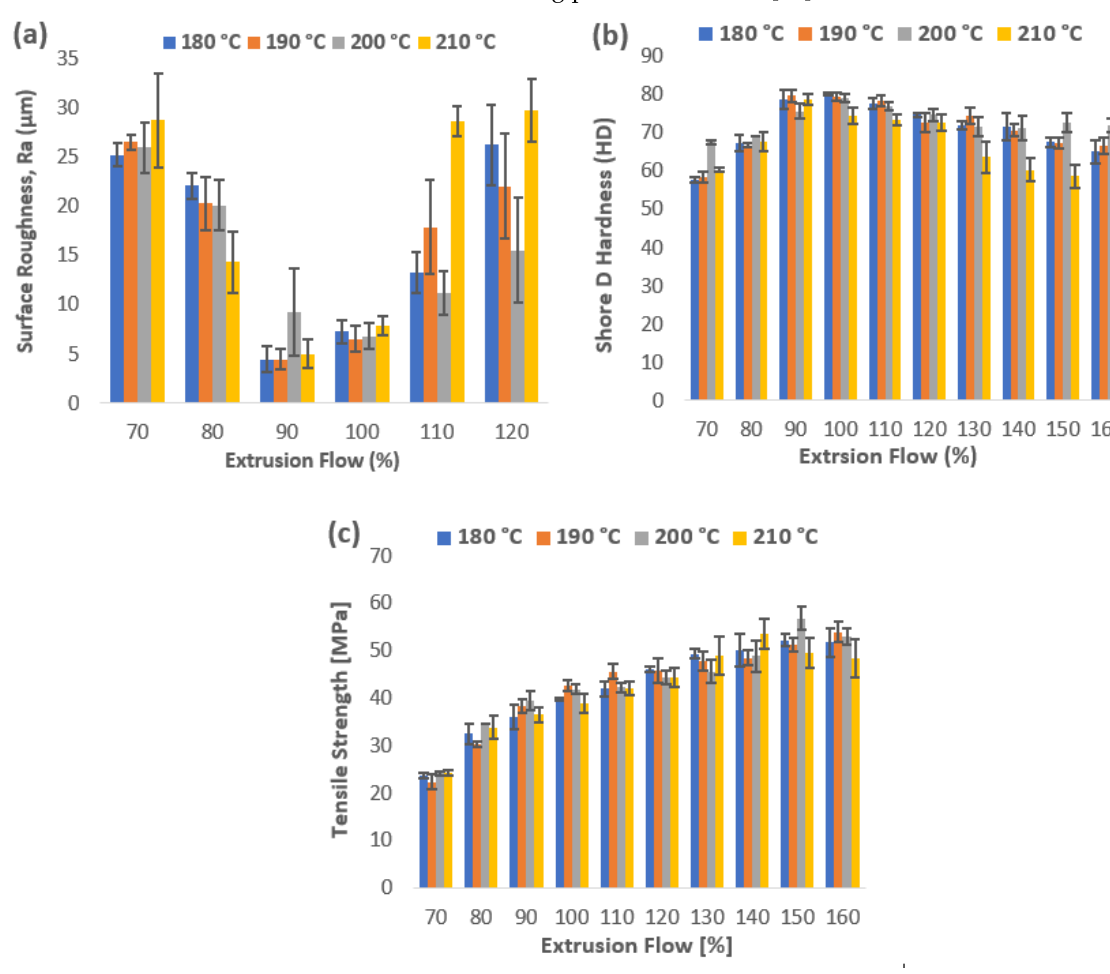
Figure 15. PLA experimental results; ( a ) Surface roughness; ( b ) Shore D hardness; ( c ) Tensile strength.